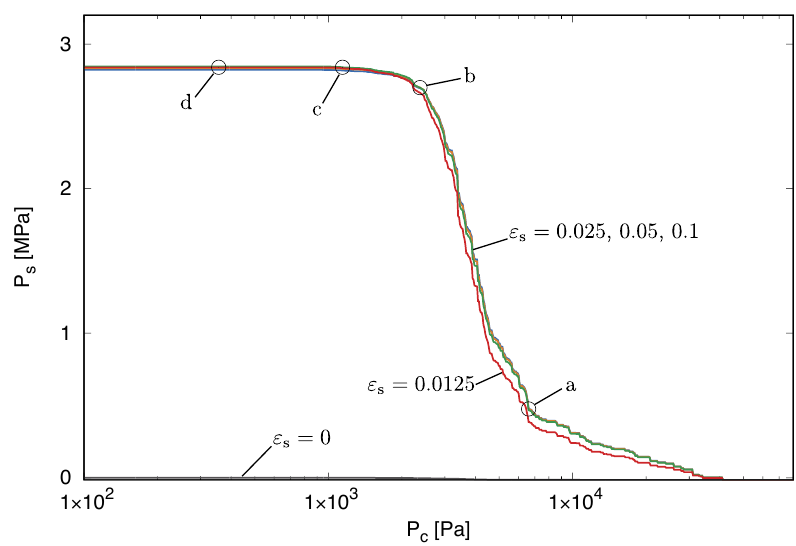
Figure 9. Constrained swelling analysis: swelling pressure P s versus capillary suction P c . The labels a, b, c and d mark stages at which the distribution of quantities within the cell are discussed